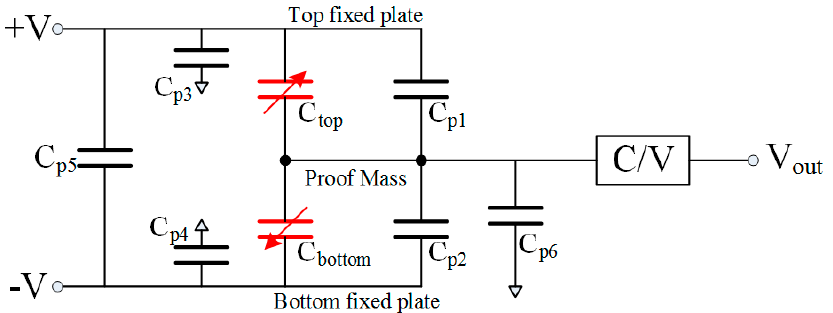
Figure 1. Schematic of capacitance in system of MEMS accelerometer.